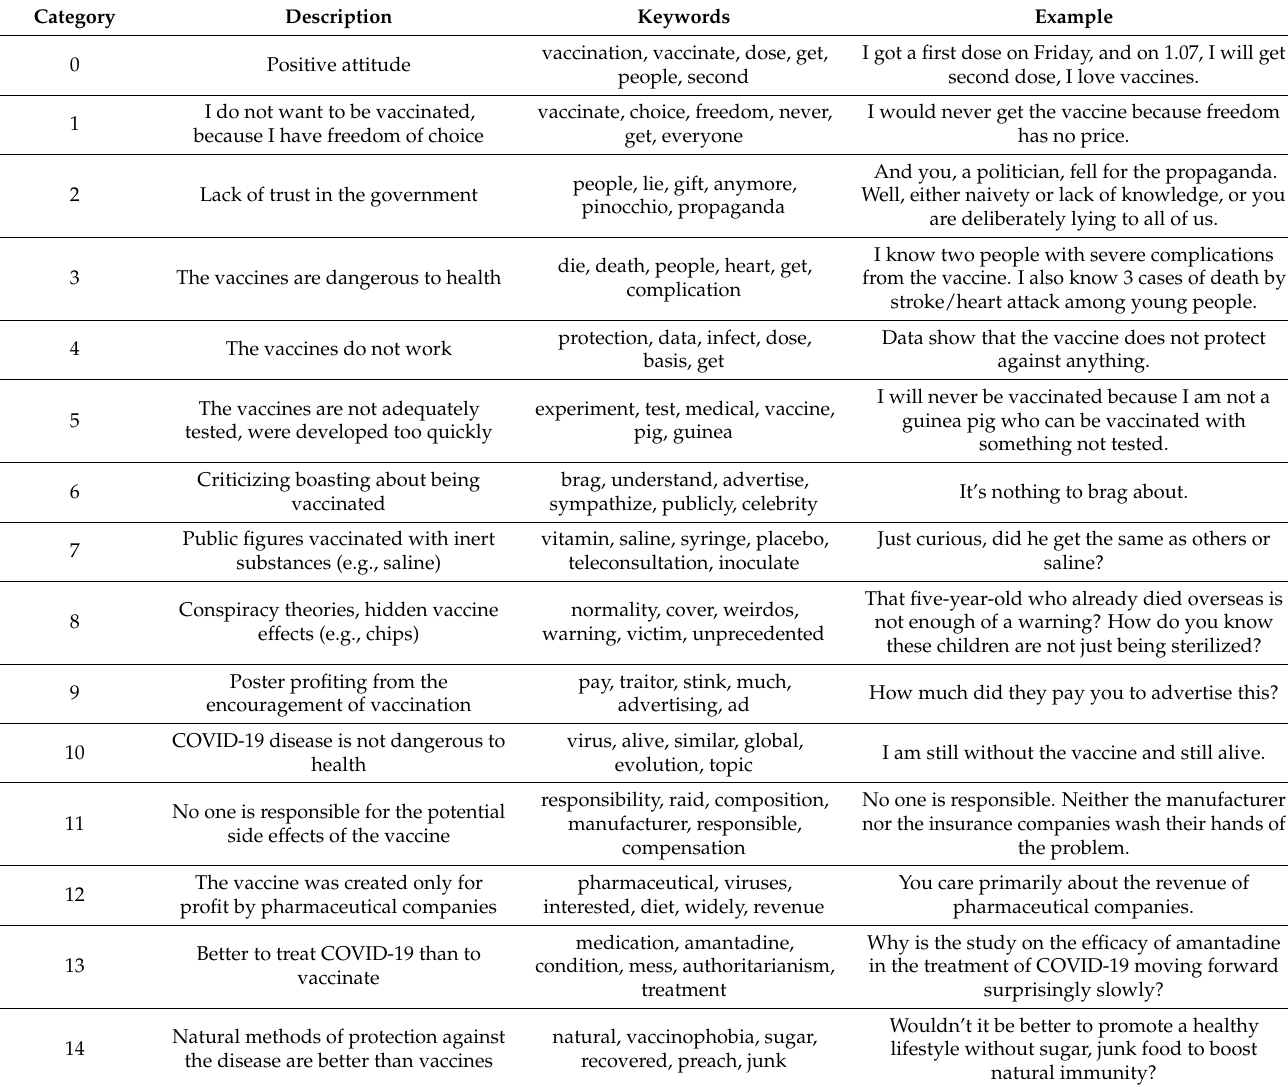
Table 3. Examples of comments by categories and